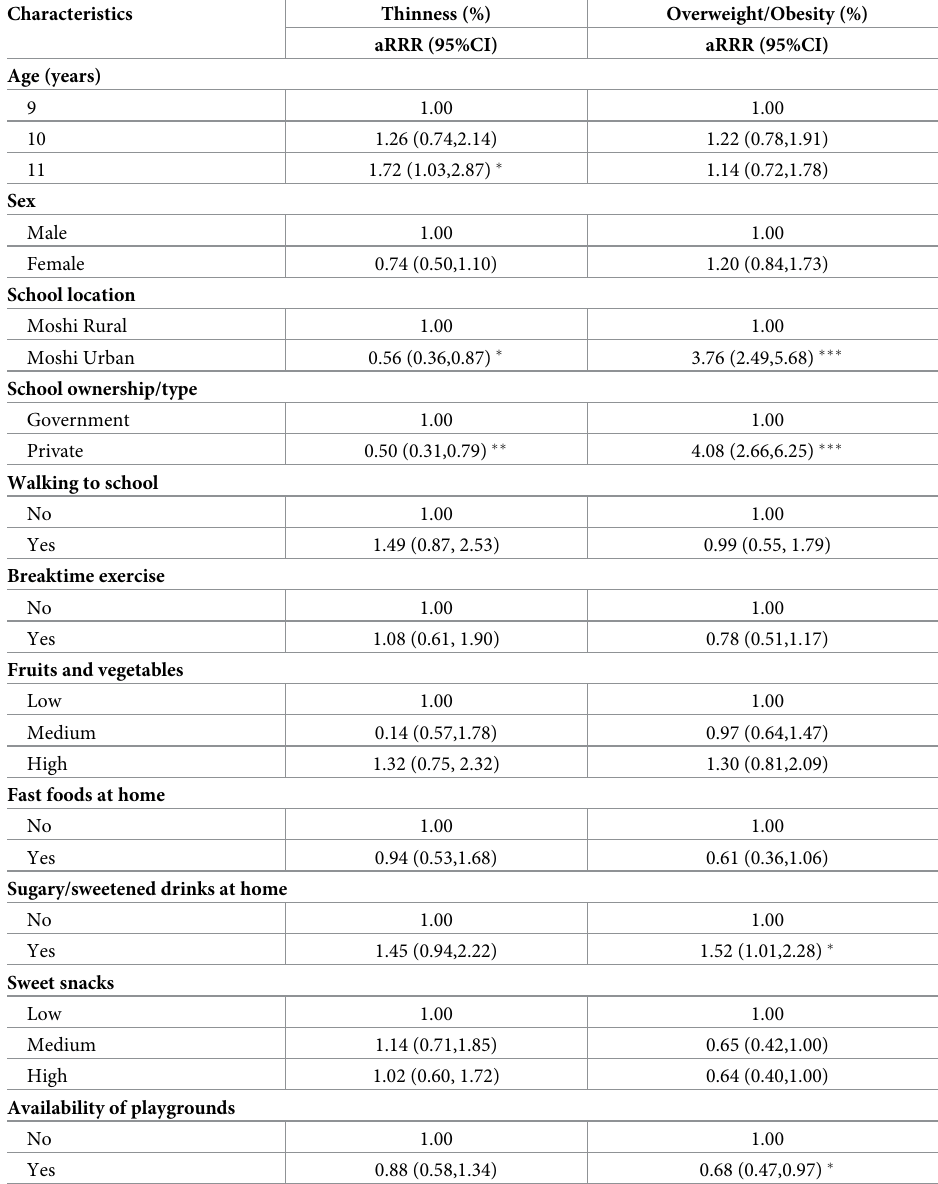
Table 5. § Adjusted correlates for overweight and obesity (N =